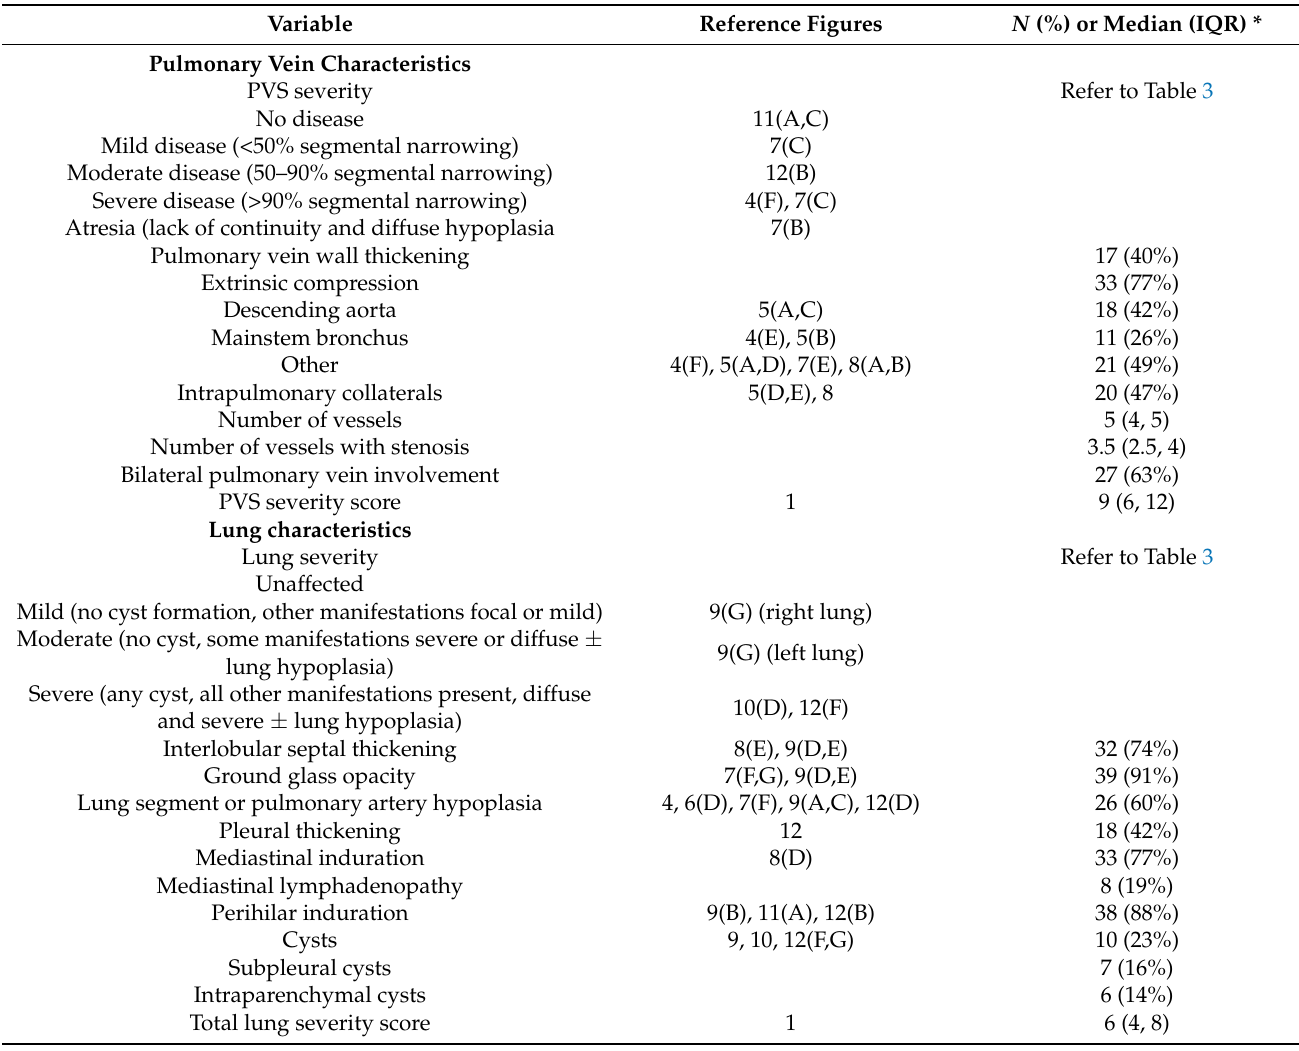
Table 2. Patient-level pulmonary vein and lung characteristics by CT ( N = 43).